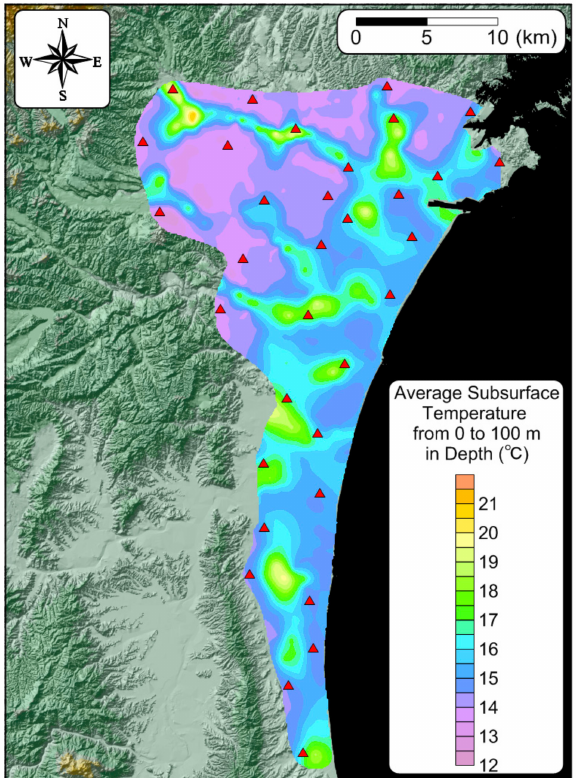
Figure 10. Distribution map of average subsurface temperature from the surface (0 m) to 100 m depth for the Sendai